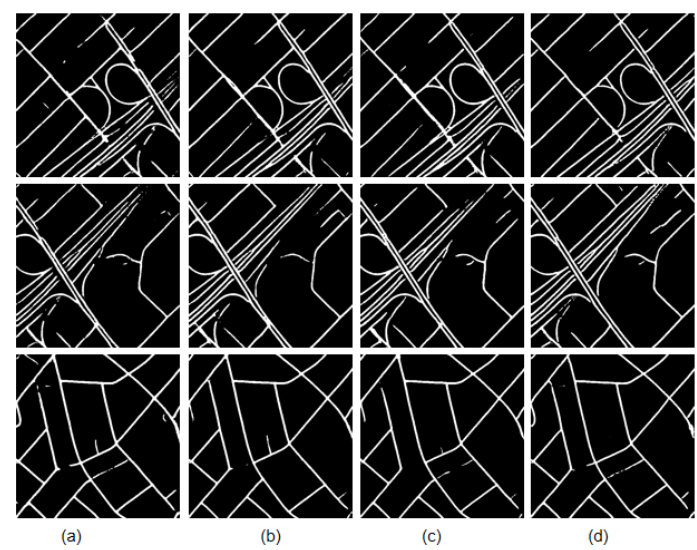
Figure 18. Comparison results of complex scene experiment. ( a ) D-LinkNetPlus_50; ( b ) D-LinkNetPlus_101; ( c ) B-D-LinkNetPlus_50; and ( d ) B-D-LinkNetPlus_101.